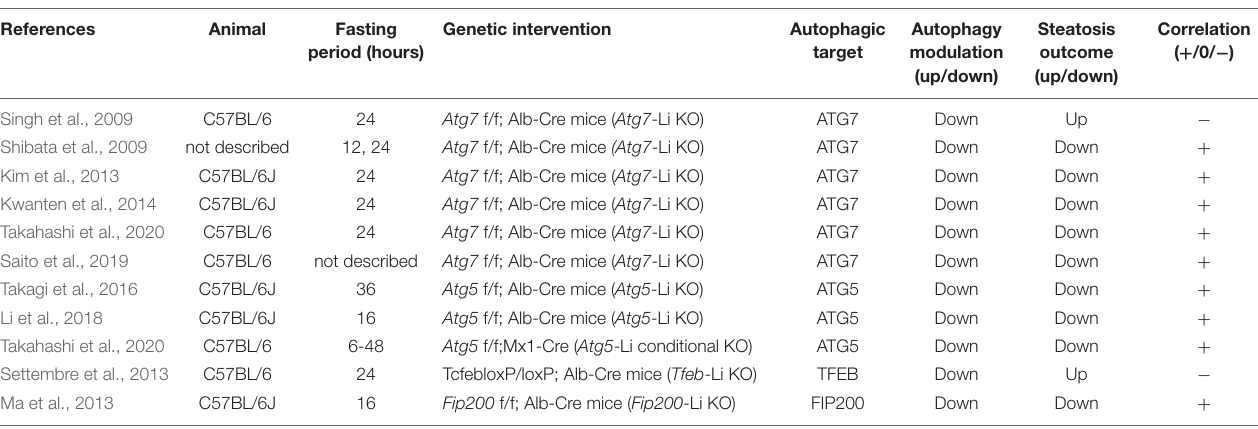
Articles using genetic interventions in the autophagy machinery and obesity models to promote steatosis, describing the diet fat content, intervention duration, liver steatosis, and LC3-II and p62 protein in levels in the liver in comparison to control groups (WT), normalized by a housekeeping protein. LC3-II and p62 were measured by the authors through SDS-PAGE Western blots and described semi-quantitatively or qualitatively. All animals were male mice. Positive correlation = steatosis is up, and autophagy is up OR steatosis is down, and autophagy is down; Negative correlation = steatosis is up, and autophagy is down OR steatosis is down, and autophagy is up. TABLE 6 | Autophagy protein genetic interventions and